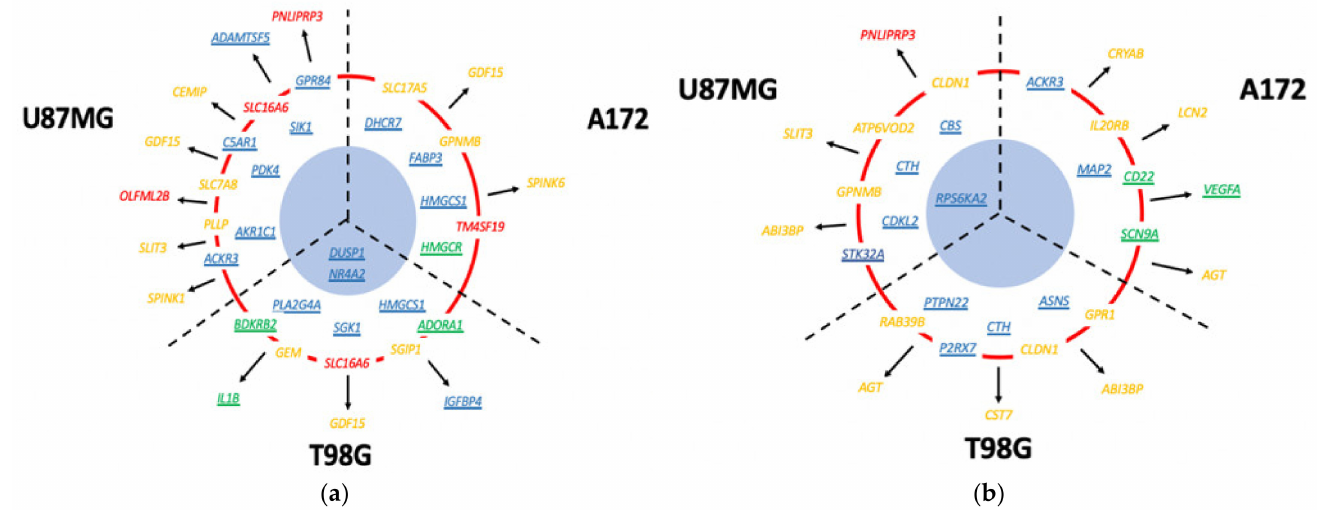
Figure 6. Summary of the most highly elevated drug induced genes encoding potential drug targets, secretory proteins and cell surface antigens expressed within the Top 25 gene set in the three GBM cell lines. ( a ) Mardepodect-treated cells; ( b ) Regorafenib-treated cells. Note the clear differences between the drug modulated phenotypes, both between GBM cell types and individual drug treatments. Targets underlined in green have existing FDA approved drugs; those underlined in blue have chemical leads but no approved drugs; those in yellow have only biological rationales, while those in red remain relatively